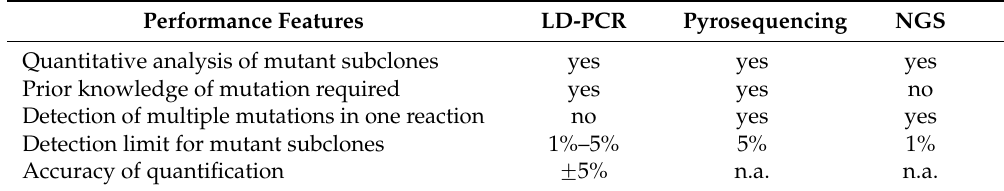
Table 4. Performance features of the methods